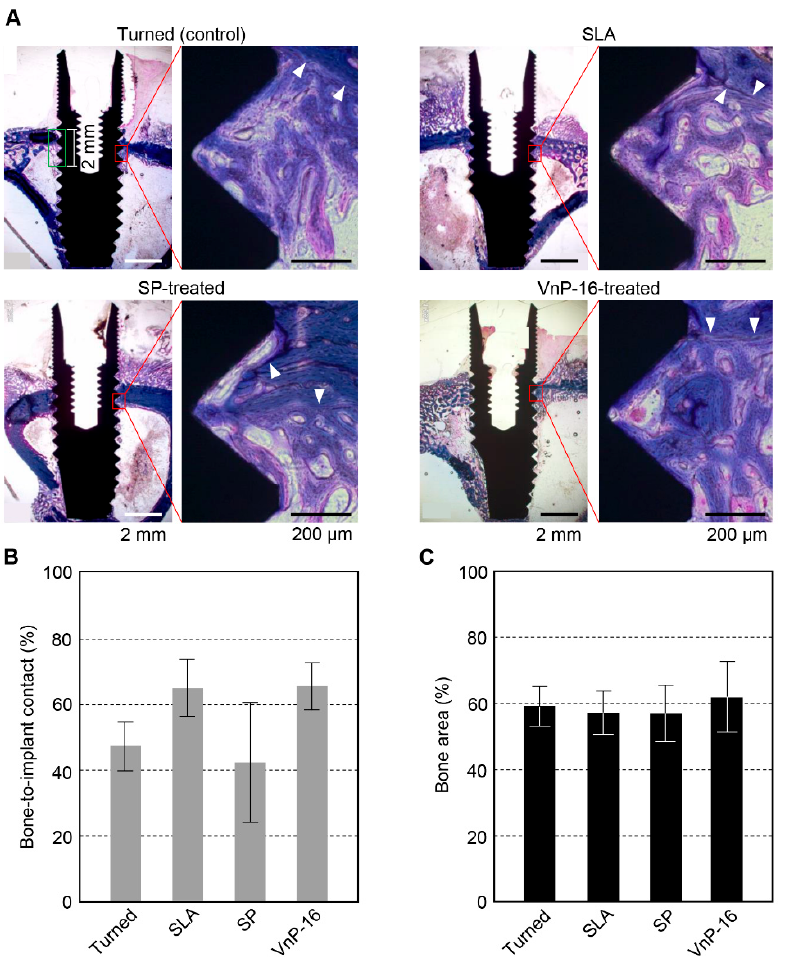
Figure 4. The histologic views and histomorphometric data for bone responses to the turned, SLA, SP-treated SLA, and VnP-16-treated SLA titanium implant surfaces. ( A ) The demarcation lines (white arrowheads), difference in stained colors and maturity of the bone (cancellous or cortical) differentiate the new bone from the existing old bone. Here, the new bone is stained more reddish while the old bone is stained more blueish. ( B ) Bone-to-implant contact ratios were measured, which are defined as the percentage of the implant surface in contact with bone to the total implant surface at the region of interest, which was the area ranging from the bone crest to 2 mm in depth in this study (green edged rectangle in ( A )). ( C ) The ratio of the area filled with bone to the total area of the region of interest (bone area, or BA ratio) was also measured for each implant.